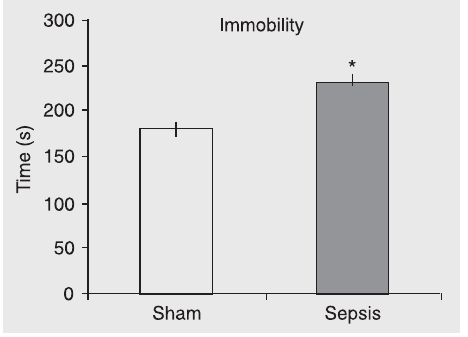
Figure 2. Forced swimming